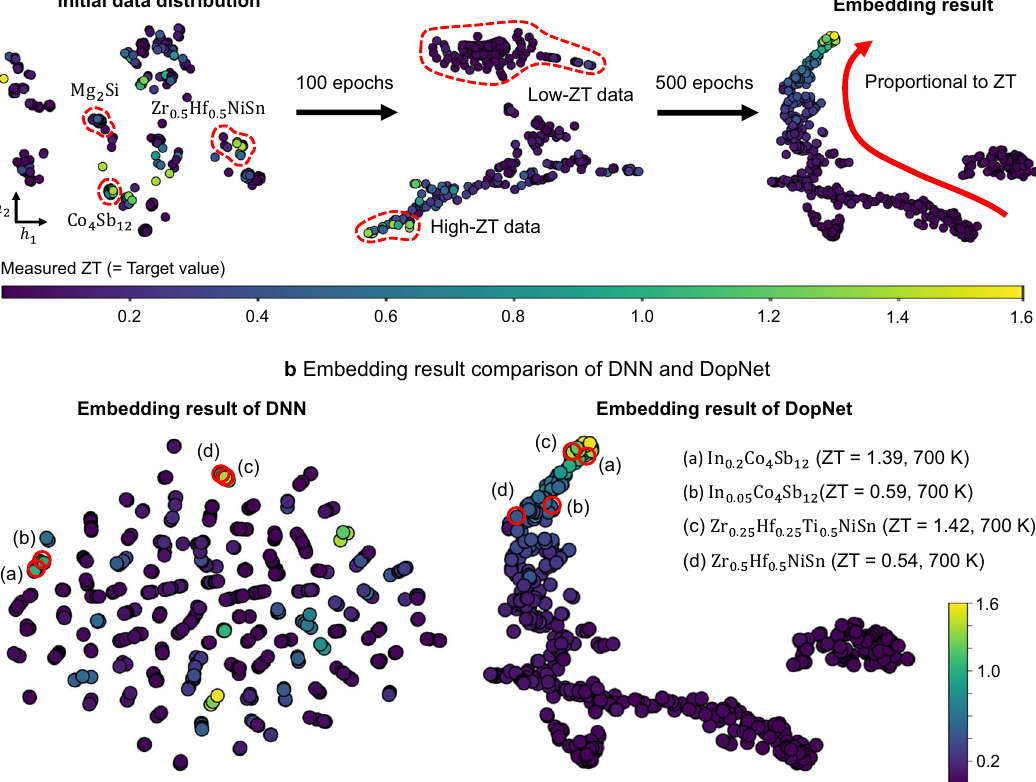
Fig. 6 2-dimensional visualization of embedding results of DNN and DopNet. a embedding results of DopNet for each epoch of the training. b embedding results comparison between FNN and DopNet. The embedding results were visualized by t-SNE 27 applied to the outputs of the last hidden layers of FNN and DopNet. Each point is the data (pair of material and temperature) in the MRL dataset, and the colors of the points indicate the values of ZTs. Two axes h 1 and h 2 indicate the fi rst and second latent features calculated by t-SNE,